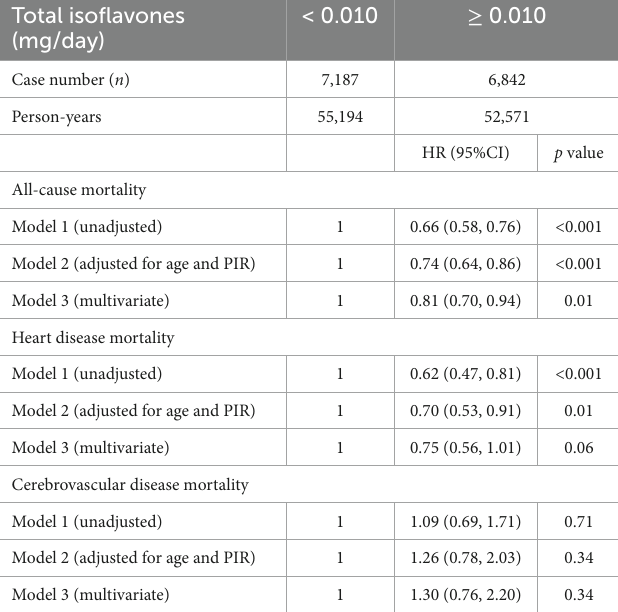
TABLE 4 Hazard ratios of mortality by isoflavone intake